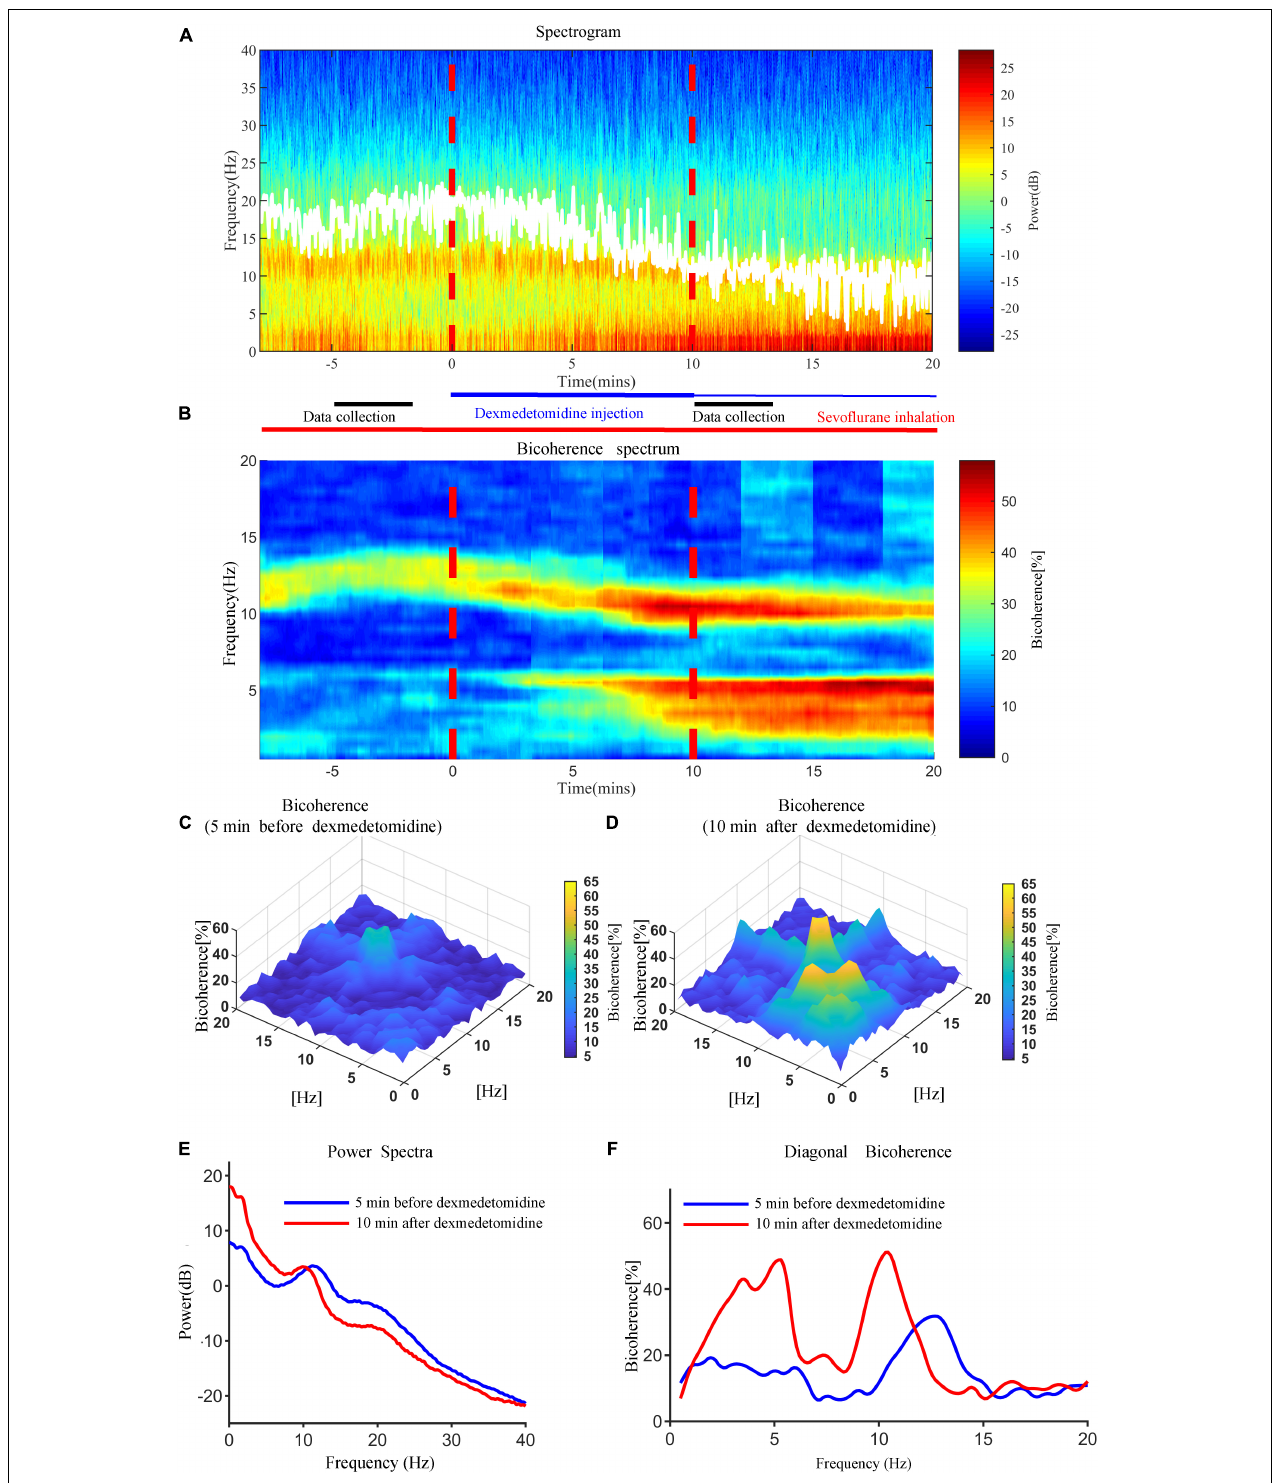
FIGURE 2 | Representative time courses of power and bicoherence spectra 5 min before and 10 min after dexmedetomidine infusion for a 29-year-old man under sevoflurane anesthesia. (A) Time-frequency spectrogram of the frontal cortex during anesthesia. (B) Bicoherence spectrum of the frontal cortex during anesthesia. White solid lines in (A) represent SEF95. (C) Bicoherence spectra 5 min before dexmedetomidine infusion for all pairs of frequencies. (D) Bicoherence spectra 10 min after dexmedetomidine infusion for all pairs of frequencies. (E) Power spectra 5 min before (blue line) and 10 min after (red line) dexmedetomidine infusion. (F) Diagonal bicoherence 5 min before (blue line) and 10 min after (red line) dexmedetomidine infusion.